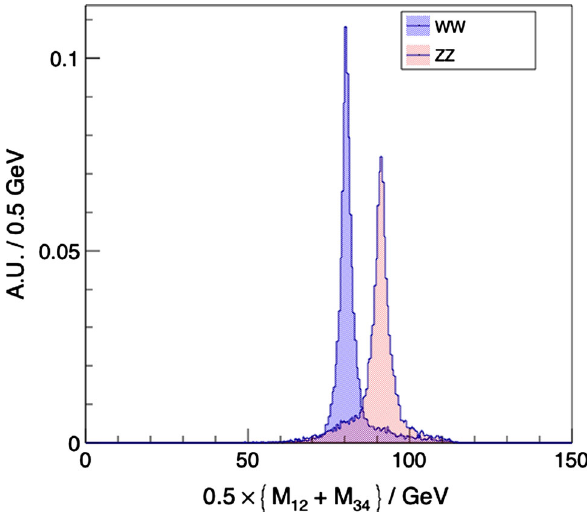
Fig. 12 The GenJet level distributions of 0 . 5 × ( M 12 + M 34 ) with the equal mass condition, the overlapping fraction is 27 . 1% ± 0 . 42%